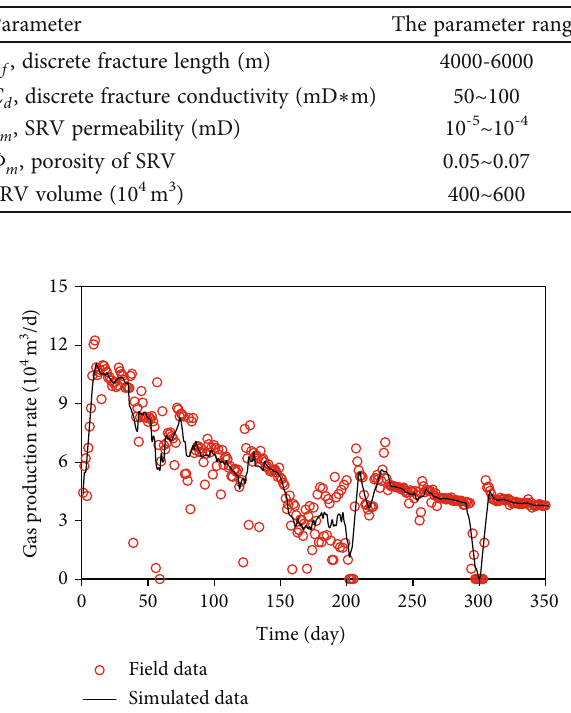
Figure 9: Gas rate history matching.